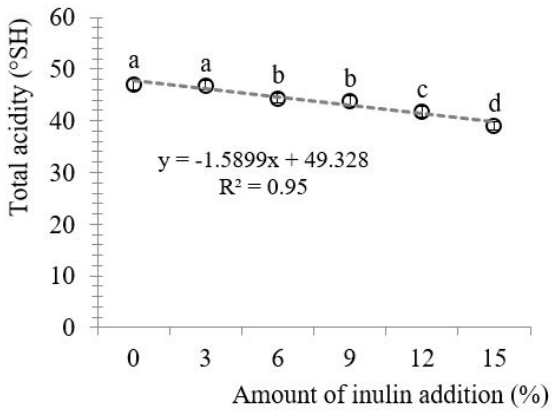
Figure 1. Total acidity (°SH) of yogurts with 0%, 3%, 6%, 9%, 12% or 15% w/w inulin addition (a, b, c…—various letters for average values mean statistically significant differences, p < 0.05).